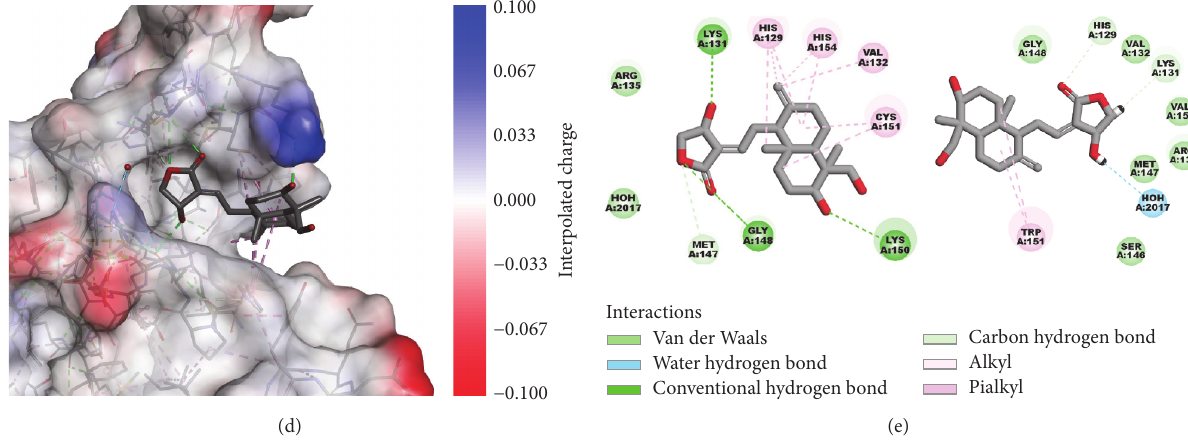
Figure 2: Effect of andrographolide on the expressions and locations of Nrf2 and Keap1. The abbreviation of andrographolide, ANDRO, was used. (a) Total Nrf2 expression was determined by Western blot analysis. The cells were treated with 1, 5, and 10 𝜇 M andrographolide for 24 h and the cell lysates were subjected to Western blot analysis. The data are presented as the means ± SE of triplicates. The significance presented as ∗ 𝑝 < 0.05 compared with control group. (b) Nuclear Nrf2 expression was determined by Western blot analysis. Lamin B was used as a nuclear loading control. The data are presented as the means ± SE of triplicates. The significance presented as ∗ 𝑝 < 0.05 compared with control group. (c) The intracellular location and deposition of Nrf2 and Keap1 were examined using immunocytochemistry. The cells were plated and incubated with 10 𝜇 M andrographolide for 24 h. Cells were immediately fixed with 3.7% formalin solution and subjected to the next steps described in the “Materials and Methods” section. (d) 3D molecular docking simulation of andrographolide to BTB domain of Keap1 was monitored in silico . The Keap1 protein was visualized by interpolated charge. (e) 2D diagram for non-covalent interactions between andrographolide and wild type or C151W mutated Keap1 was